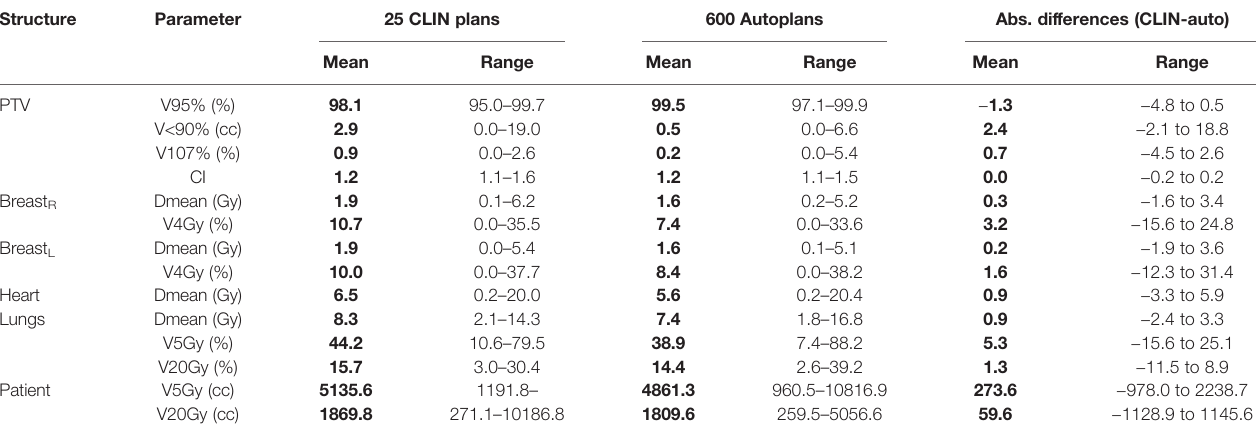
TABLE 1 | Comparisons of mean (and ranges) autoplan parameters (units are given in parameter column) with corresponding mean (and ranges) clinically delivered plan (CLIN) parameters for patients 1 – 25, and absolute differences (mean and ranges). Structure